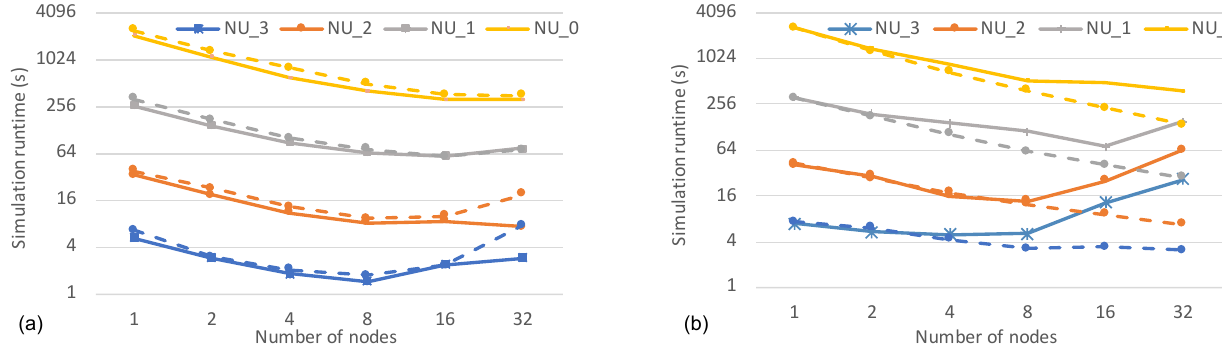
Figure 9. Performance scaling on (a) Peta-5–CPU (Intel Xeon CPU) and (b) Peta-5–KNL (Intel Xeon Phi) at different mesh sizes with pure MPI (solid) and MPI+OpenMP (dashed).